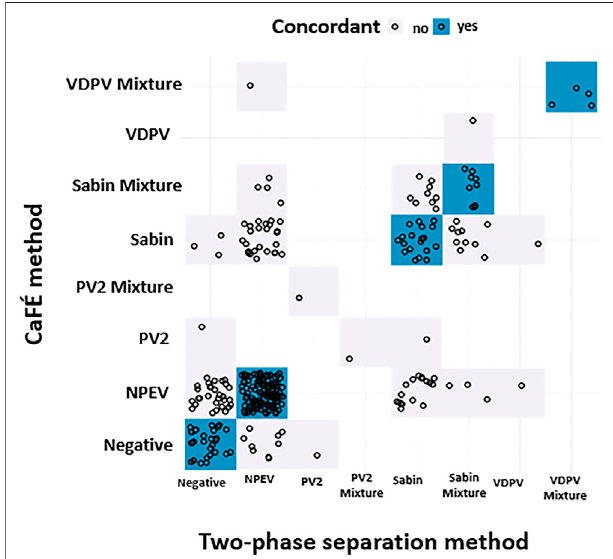
FIGURE 4 | Poliovirus screening results forthe parallel and pilot studies between two-phase separation method and CaFÉ method by poliovirus genotype (n = 345), negative for poliovirus or mixture of multiple polioviruses. NPEV =non-poliovirusenterovirus, Sabin=Sabin-liketype1or3,PV2 = Poliovirus type 2, VDPV = Vaccine Derived poliovirustype 1, 2 or